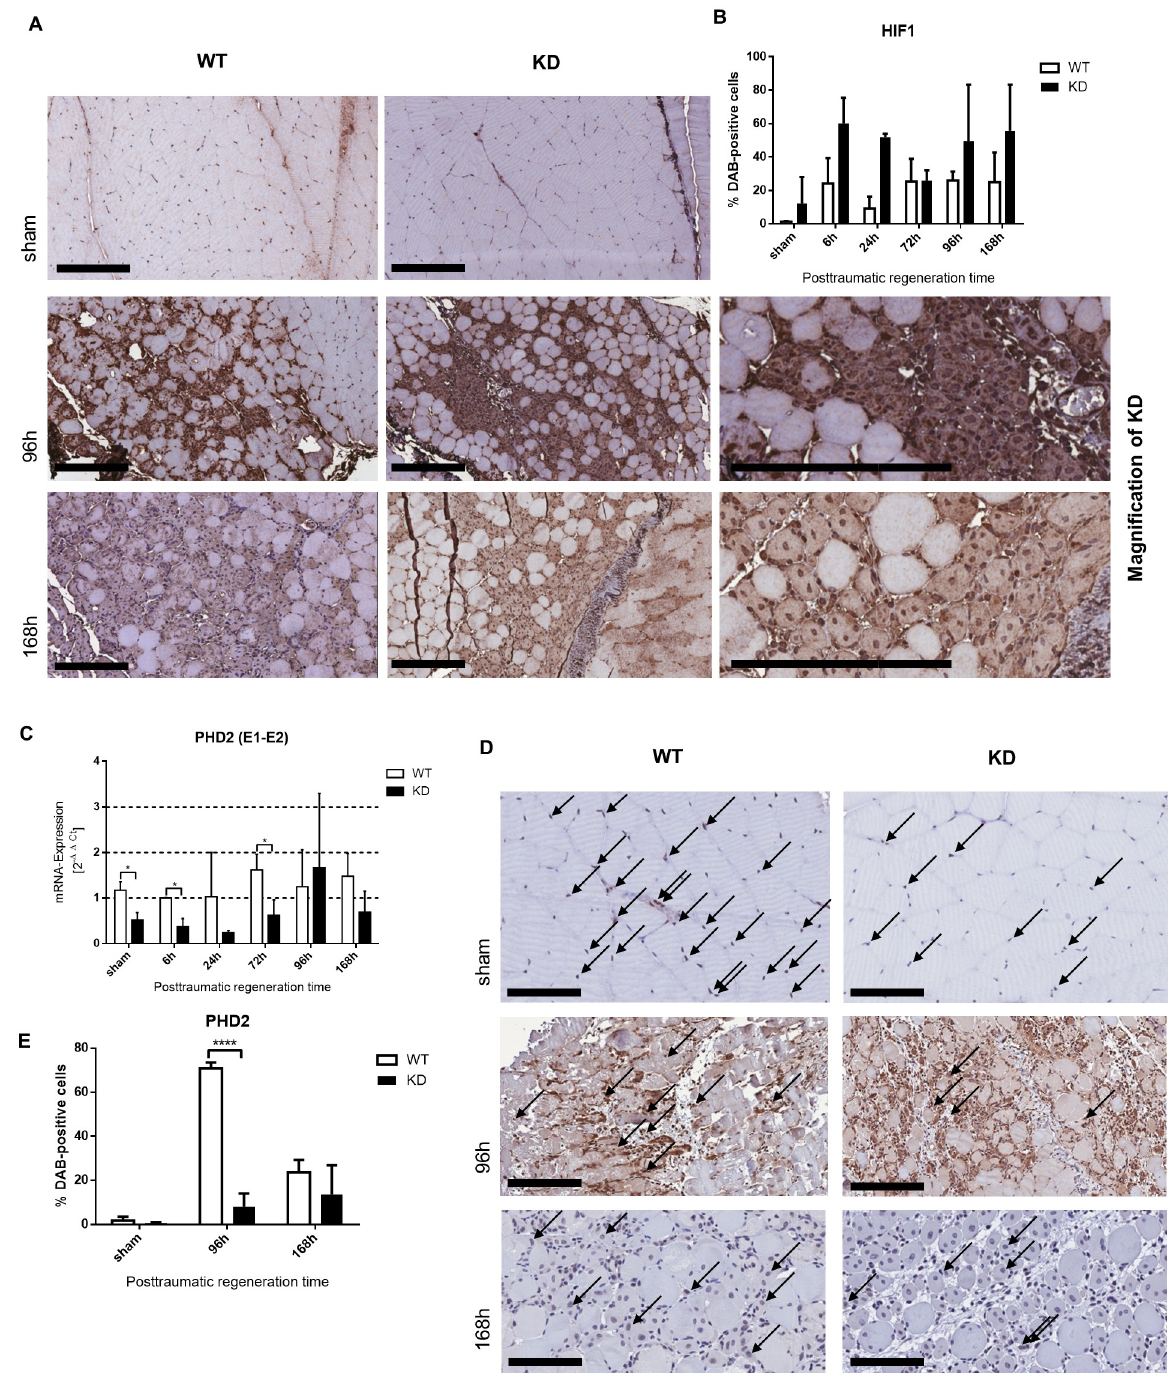
Fig 3. HIF-1 α protein stabilization in myotrauma is comparable between WT and KD. (A) Immunohistochemical staining of HIF-1 α in skeletal muscle of traumatic and sham treated wild type (WT) and Phd2 -hypomorphic (KD) mice. Cell nuclei positive for HIF-1 α at early time points are restricted to invaded immune cells. Over time there are increasing numbers of HIF-1 α positive myonuclei. Shown are slides of 1 μ m thickness (200x magnification; 600x magnification; scale bar: 200 μ m). (B) Quantification of presented immunohistochemical staining (% of DAB-positive cells) of regenerating muscle cells. (D) Immunohistochemical staining of PHD2 in skeletal muscle of traumatic and sham treated wildtype (WT) and Phd2 -hypomorphic (KD) mice. Seven days after myotrauma, Phd2 -hypomorphic mice exhibited reduced numbers of positively stained myonuclei in representative regenerating areas compared to wild type mice (arrows). Shown are slides of 1 μ m thickness (200x magnification; scale bar: 200 μ m). (C) qPCR analysis (whole muscle tissue) of Phd2 Exon 1 (E1)—Exon 2 (E2) for knockdown control (E) analysis of DAB-positive cells in areas containing almost exclusively regenerating muscle cells revealed lower PHD2 staining; mean ± SD; n = 4–8; sham: n = 3. � P < 0.05. https://doi.org/10.1371/journal.pone.0233261.g003 PLOS ONE | https://doi.org/10.1371/journal.pone.0233261 May 15,